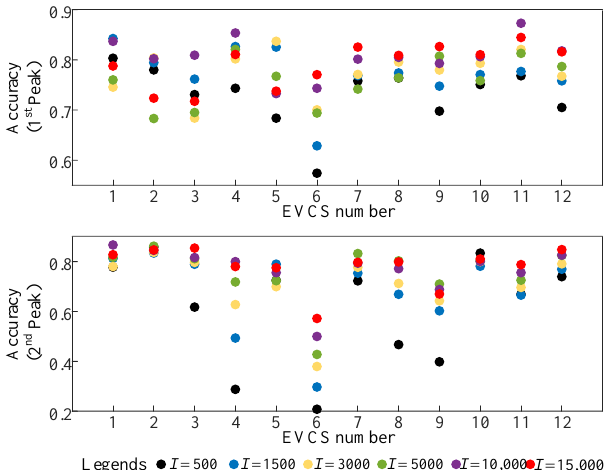
Figure 4. Road speed derived from Greenshield model. E ≤ 0.1 regards convergence of the point. The results are evaluated in the form of accuracy (i.e., number of convergence points divided by all variance non-zero value points).